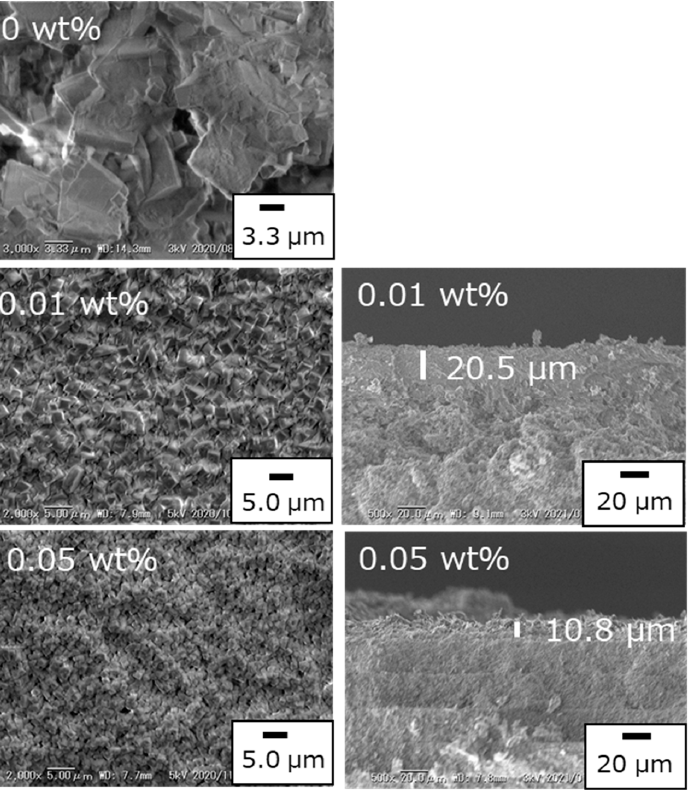
Figure 5. The effect on the morphology of pure silica CHA zeolite membranes by adding seed crystals (1 SiO 2 :0.8 TMAdaOH:0.8 HF:4.6 H 2 O, x wt% CHA seeds, 16 h at 423 K).